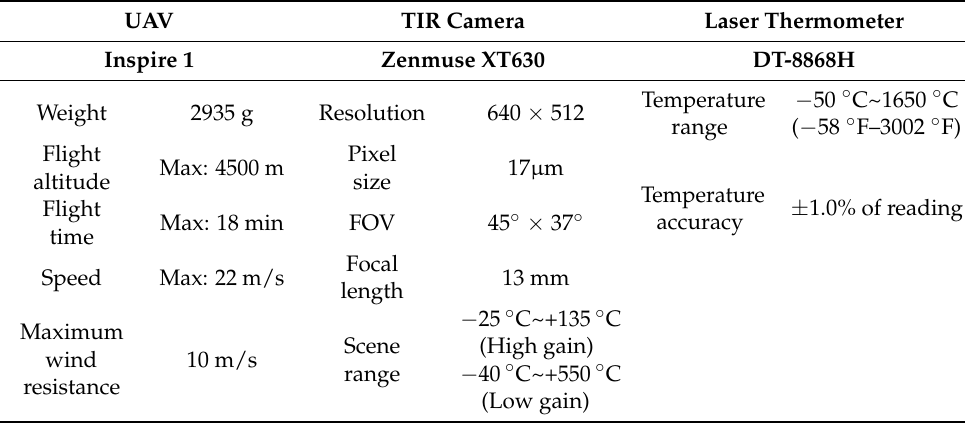
Table 1. UAV, TIR camera and laser thermometer